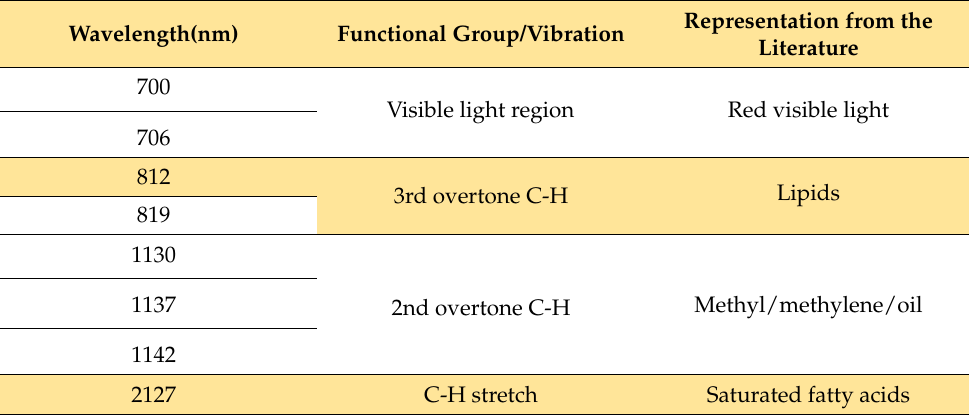
Table 4. A summary of prominent wavelengths identified for DENV1 in plasma and their indicative functional groups from the literature